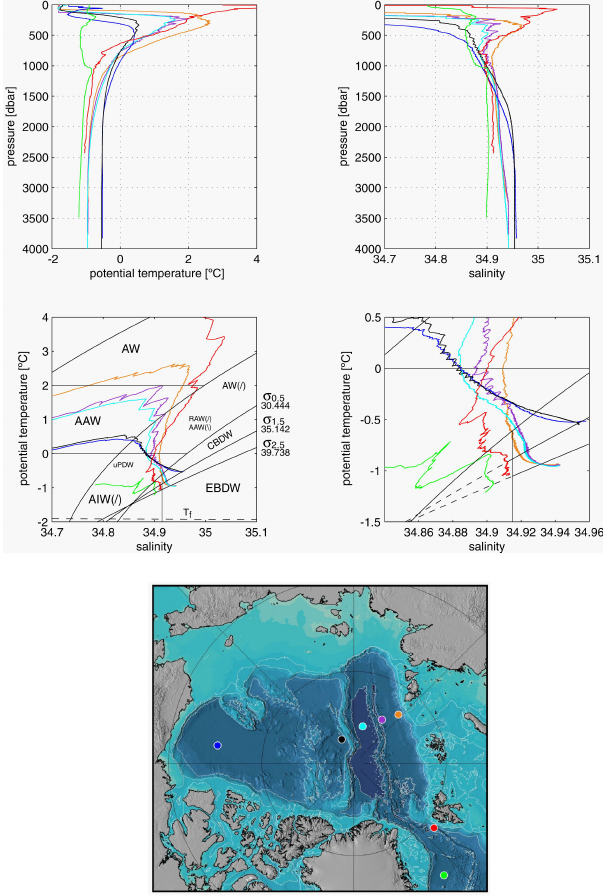
Fig. 10. Potential temperature and salinity profiles and θS curves showing the characteristics of some water masses in the Arc- tic Mediterranean. Green station, Greenland Sea, red station, Fram Strait, orange station, Nansen Basin slope, magenta sta- tion, Gakkel Ridge, cyan station, Amundsen Basin, black station, Makarov Basin, blue station Canada Basin. AW (Atlantic Water), AAW (Arctic Atlantic Water), RAW (Recirculating Atlantic Water), uPDW (upper Polar Deep Water), AIW (Arctic Intermediate Wa- ter), CBDW (Canadian Basin Deep Water), EBDW (Eurasian Basin Deep Water), NDW (Nordic Seas Deep Water). (/) indicates unsta- ble stratification in either temperature or salinity, and ( \ ) indicates stable stratification in both components. From Rudels